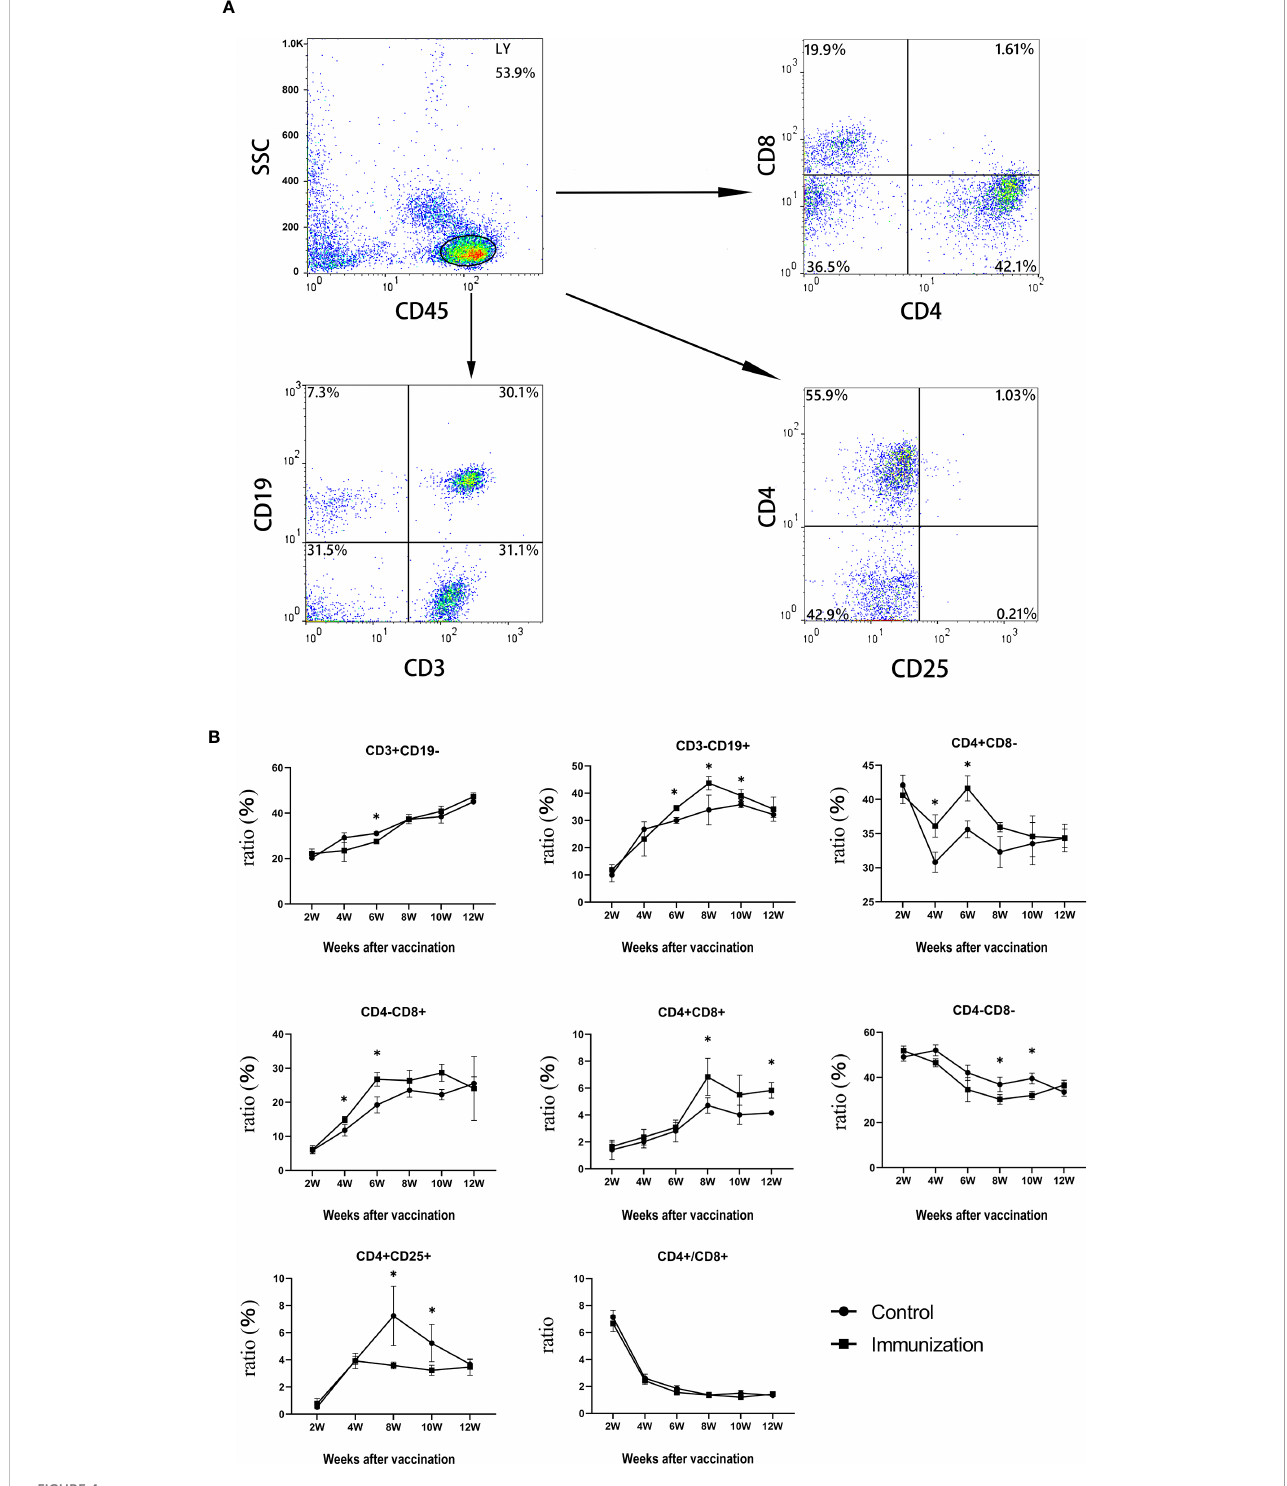
FIGURE 4 (A) The proportions of lymphocytes in blood of rats were separated and were analyzed by fl ow cytometry compared to control groups.Up left is CD45, up right is CD4 and CD8(CD45 for gate), down left is CD3 and CD19(CD45 for gate),down right is CD4 and CD25(CD45 for gate), (B) Mean (± SEM) of the serum CD3+CD19- 、 CD3-CD19+ 、 CD4+CD8- 、 CD4-CD8+ 、 CD4+CD8+ 、 CD4-CD8- 、 CD4+CD25+ and the ratio of CD4+ and CD8+ (all from the gate of CD45+ cells)concentrations in the gonadotropin-releasing hormone (GnRH) immunization group (n = 35) and control group (n = 35). Flow cytometry was used to detect the number of immune cells. The ordinate is the ratio of immue cytokine. The abscissa is the age of weeks after fi rst immunization. * Indicates a signi fi cant difference ( P